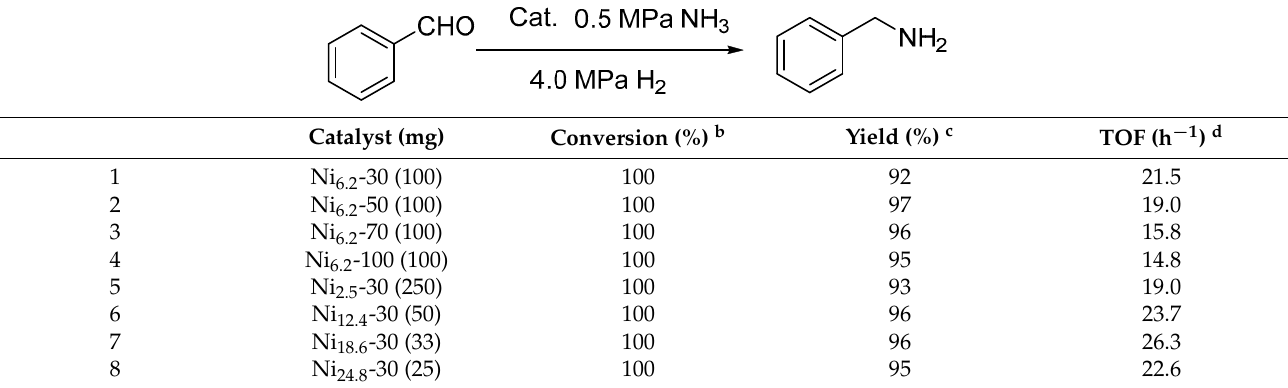
Table 3. Reduction of aldehyde-ammonia by different catalysts a .